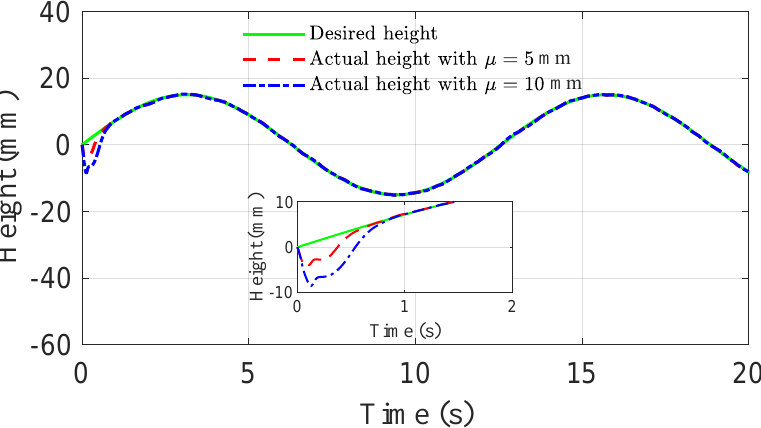
Figure 3. Height tracking performance of quarter vehicle with AAS in co-simulation.